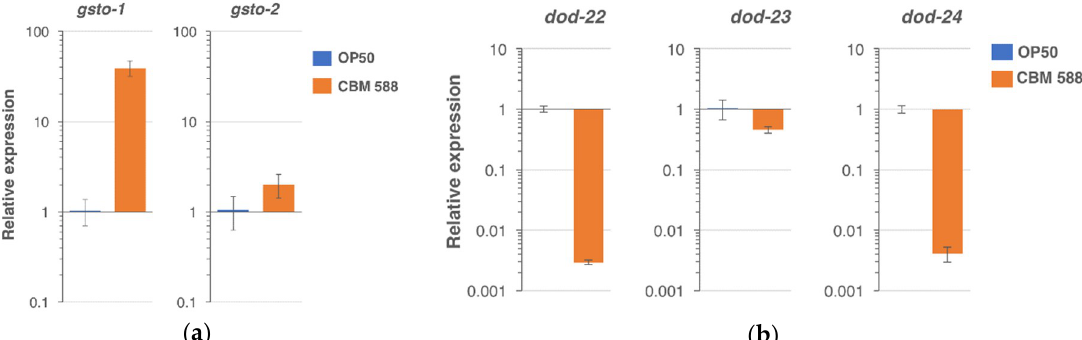
Figure 4. Relative gene expression (determined using real-time PCR) in the animals fed CBM 588 in comparison with control (OP50). ( a ) The gsto-1 and gsto-2 expression was upregulated by the CBM 588 feeding. ( b ) The expression of dod-22 , dod-23 , dod-24 was downregulated by CBM 588. Error bars indicate S.D. n = 3 biological replicates.